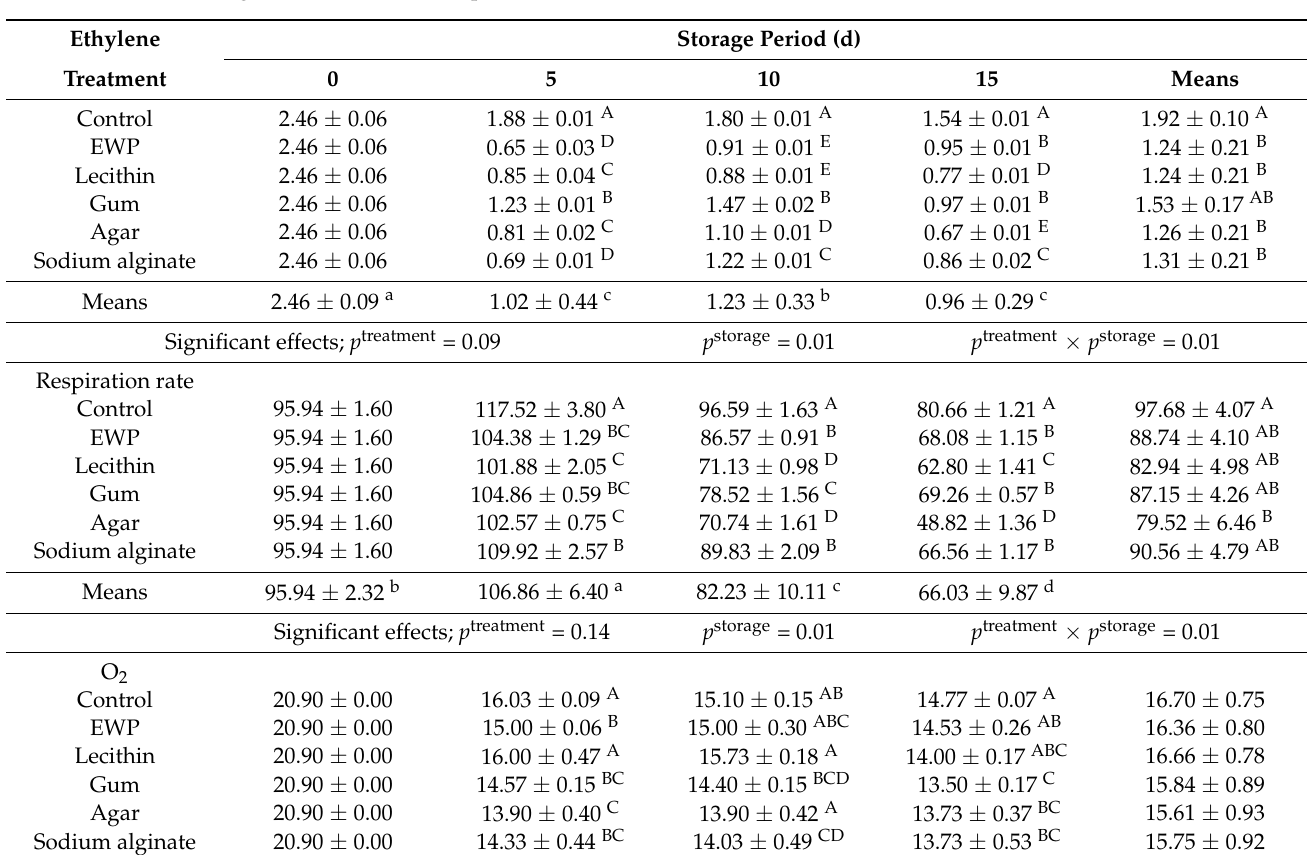
Table 3. The changes in respiration rate, ethylene production, O 2 , and CO 2 inside the packages during the storage of button mushrooms during 15 d at 4 ◦ C. Data are presented as means ±